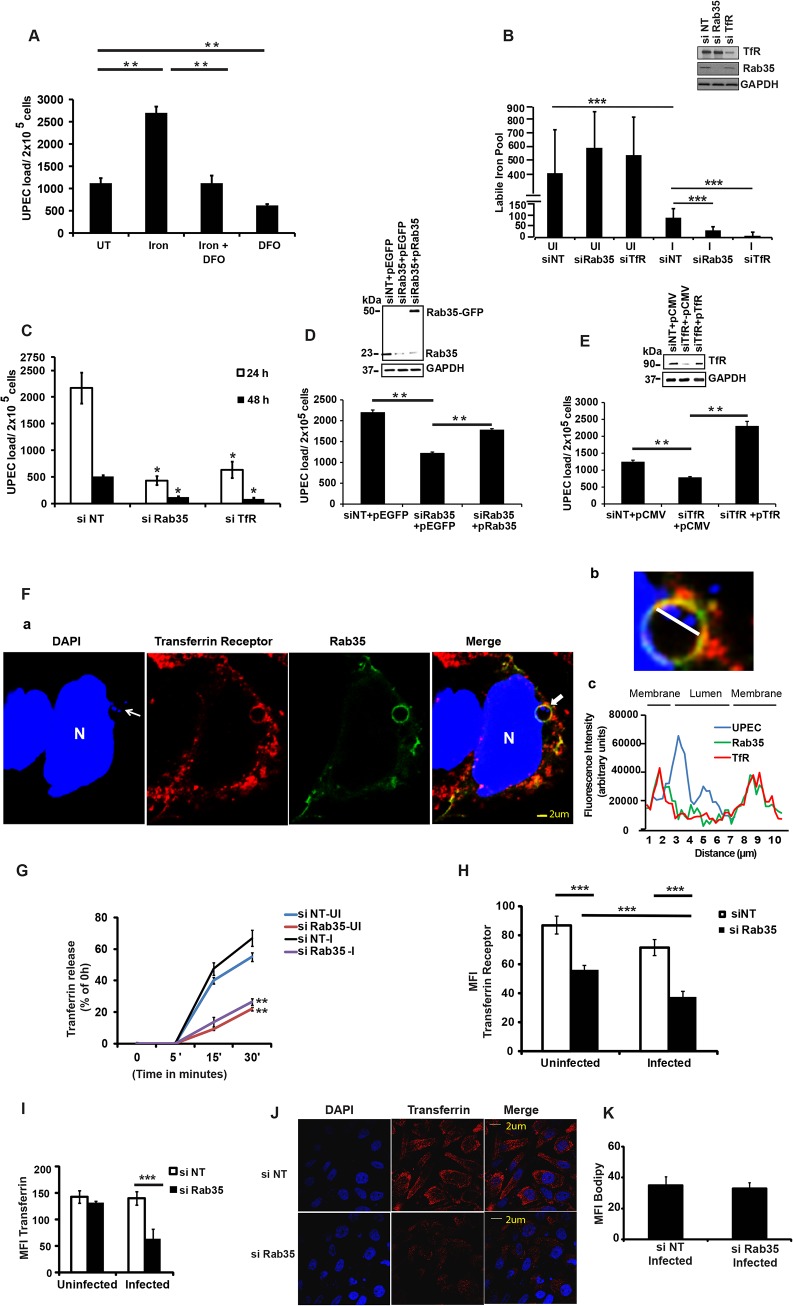
Iron acquisition via Rab35/transferrin receptor 1 pathway is critical for the intracellular survival of UPEC within BEC.
(A) UPEC-Infected BEC cells were either left untreated (UT) or treated with holotransferrin (iron), deferoxamine (DFO) or iron+DFO in serum-free conditions. The intracellular bacterial load was determined 24 h post-infection by lysing the cells in 0.1% Triton X-100 and plating on LB-agar. B BEC cells transfected with si NT, si Rab35 or si TfR were left either uninfected or infected with UPEC. Intracellular iron levels at 24 h post infection were determined by calcein-AM fluorescence as described in materials and methods. Immunoblotting was done to confirm the knock down efficiency of Rab35 and TfR siRNA (inset panel). C. BEC cells were transfected with si TfR, si Rab35 or siNT for 48 h followed by infection with UPEC. Intracellular bacterial load at different time points was determined as described before. D and E. BEC-5637 cells were transfected with 100nM each of 3’ UTR si Rab35 (D) 3’ UTR si TfR (E). 24 h following knockdown, the cells were transfected with either empty vector control or plasmids encoding Rab35 (D) or TfR (E) for 24 h. Cells were subsequently serum starved for 4 h and infected with UPEC at MOI 500. The infected cells were finally left in Gentamycin (10 μg/ml)—RPMI with 3% serum. Intracellular bacterial load was determined at 24 h. Immunoblotting was done to confirm the knockdown and over expression efficiency (inset panels). F. BEC cells were transfected with GFP-Rab35 for 24 h followed by UPEC infection for 24 h; fixed, permeabilised, stained for intracellular Transferrin Receptor and analyzed by confocal microscopy. Rab35 (green), DAPI {blue, host nuclei or bacteria (UPEC)}, and Transferrin receptor (red). Arrows in the DAPI panel indicate UPEC colonies. Panel b shows the magnified image of the UCV marked by arrows in the merged image {(optical magnification (63x) and electronic zoom (3.7x)}. The graph (panel c) shows the quantification of the fluorescence intensity along the white line shown in panel b. N, host nucleus. Both Rab35 and TfR colocalized at the UCV. The experiment was repeated three times with similar results and a representative image is shown. G. si NT and si Rab35 cells were either left uninfected or infected with UPEC for 24 h. Subsequently, the cells were loaded with Alexa 568 labelled transferrin for 20’ at 37°C. Unbound Transferrin was removed and the cells were incubated with RPMI containing unlabelled holotransferrin for the given time points. The cells were fixed and analyzed for intracellular Transferrin by confocal microscopy. Transferrin receptor recycling (Transferrin release) was measured as % of intracellular Transferrin at 0h - intracellular Transferrin at the given time point. H si NT and si Rab35 cells were either left uninfected or infected with UPEC. 24 h later the cells were fixed and stained for cell surface Transferrin Receptor and represented as Mean fluorescence intensity (MFI) and analyzed by confocal microscopy. I and J. si NT and si Rab35 BEC cells were either left uninfected or infected with UPEC. 24 h later the cells were loaded with Alexa 568 labelled transferrin for 20’ at 37°C. After removing the unbound Transferrin the cells were fixed and analyzed for intracellular Transferrin by confocal microscopy. Mean fluorescence intensity (MFI) is shown in the graph (I). The confocal microscopy experiments were repeated three times with similar results and a representative Fig for the infected samples are shown in (J). Transferrin (red). K. Infected si NT and si Rab35 cells were loaded with Bodipy 493/503 at 24 h post infection. The cells were subsequently fixed and analyzed for lipid staining by confocal microscopy and represented as MFI. Data represent mean ± standard deviation of results of three independent experiments (A, B, C, D, E, G, H, I and K). * represents p<0.05, **represents p<0.01. *** represent p<0.001. Results of (A), (C), (D) and (E) are expressed as bacterial load/ 2x105 cells. si = siRNA, si NT = negative control siRNA.